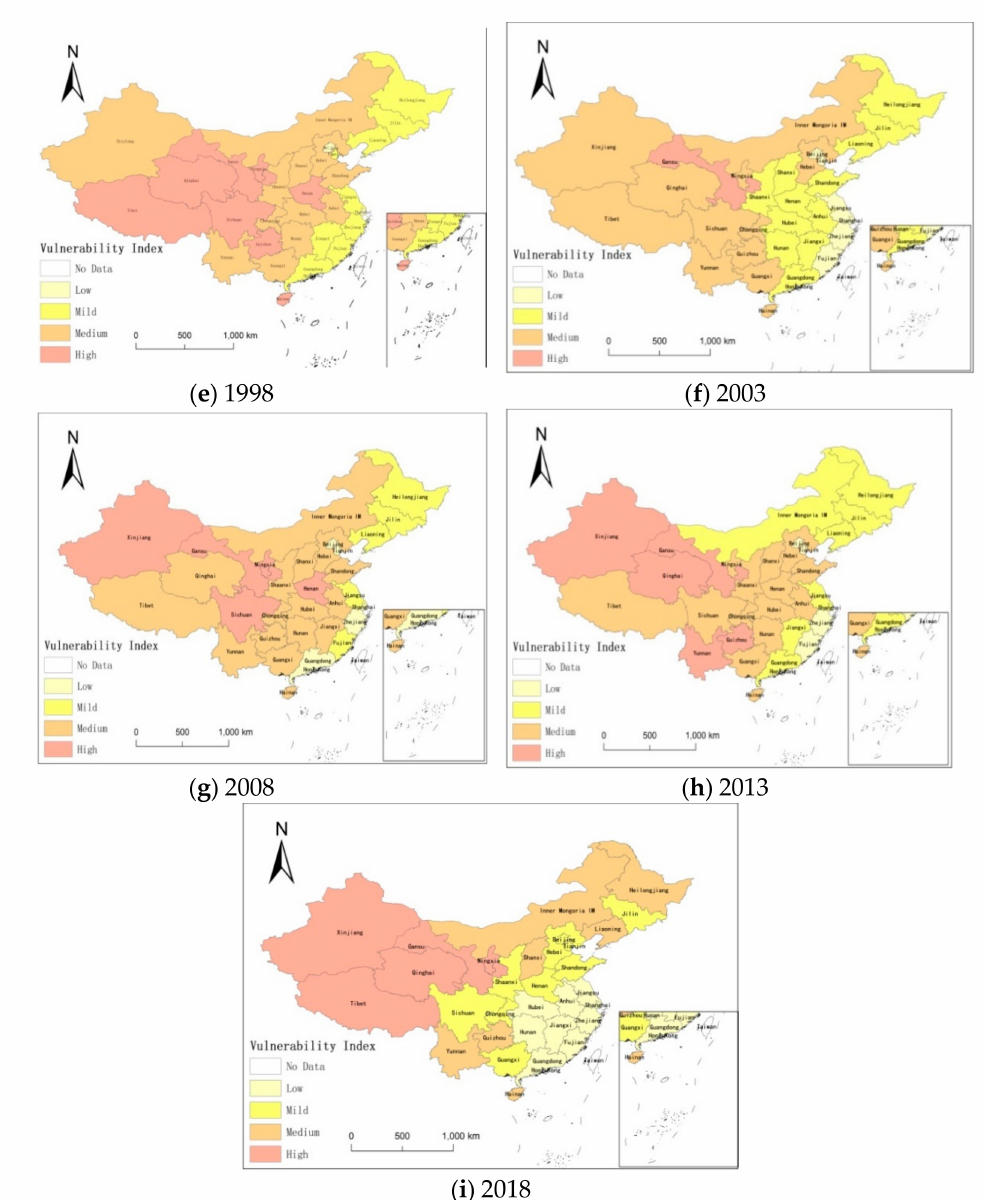
Figure 1. Spatiotemporal evolution of agricultural drought vulnerability in China ( a – i